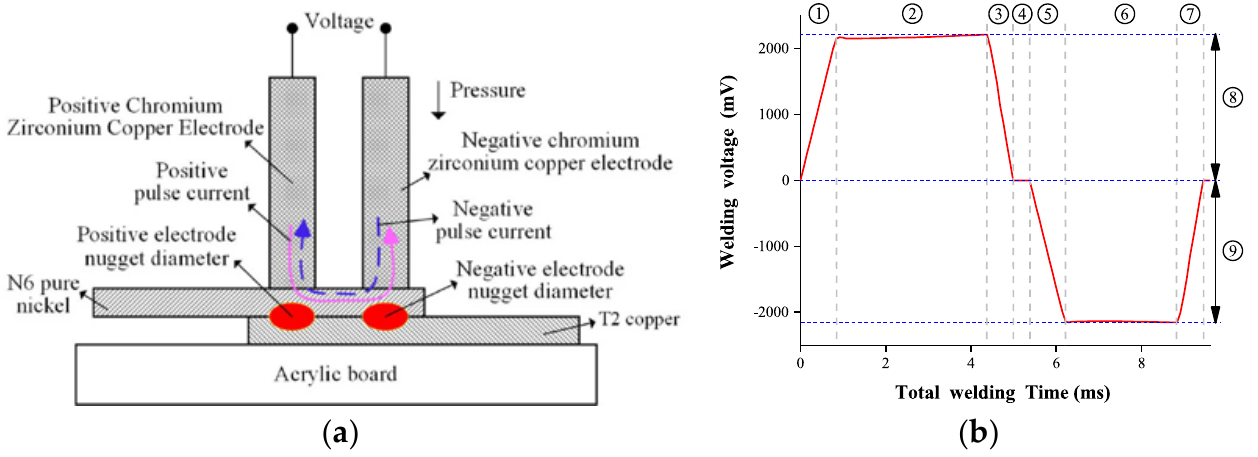
Figure 4. Resistance spot welding test. ( a ) Parallel gap single-sided double spot − welding schematic; ( b ) welding voltage waveform. Table 1. Meaning of voltage waveform segmentation.